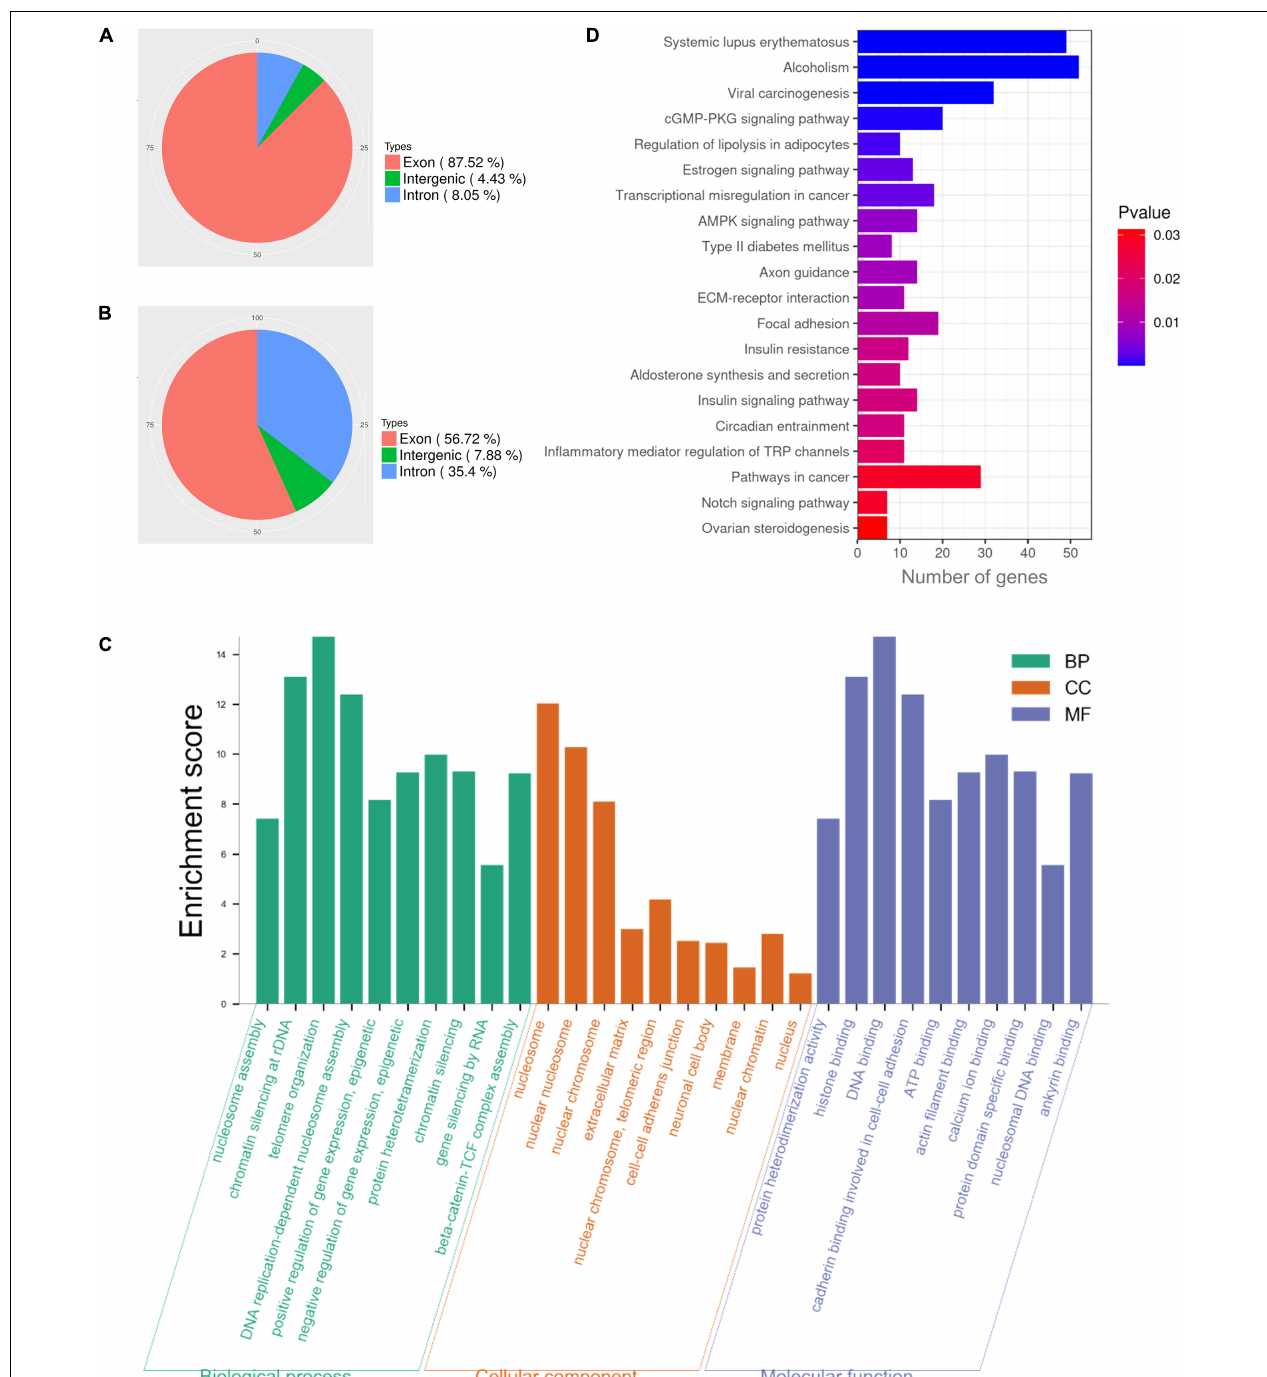
FIGURE 3 | Functional enrichment analysis of NAT10-binding transcripts in HEK293T cells. (A) Distribution of reads from input. (B) Distribution of NAT10-binding reads. (C) GO enrichment analysis of RIP-binding transcripts. (D) KEGG analysis of NAT10-RIP transcripts. RIP, RNA immunoprecipitation. GO, Gene Ontology. BP, Biological Processes. MF, Molecular Functions. CC, Cellular Components. KEGG, Kyoto Encyclopedia of Genes and